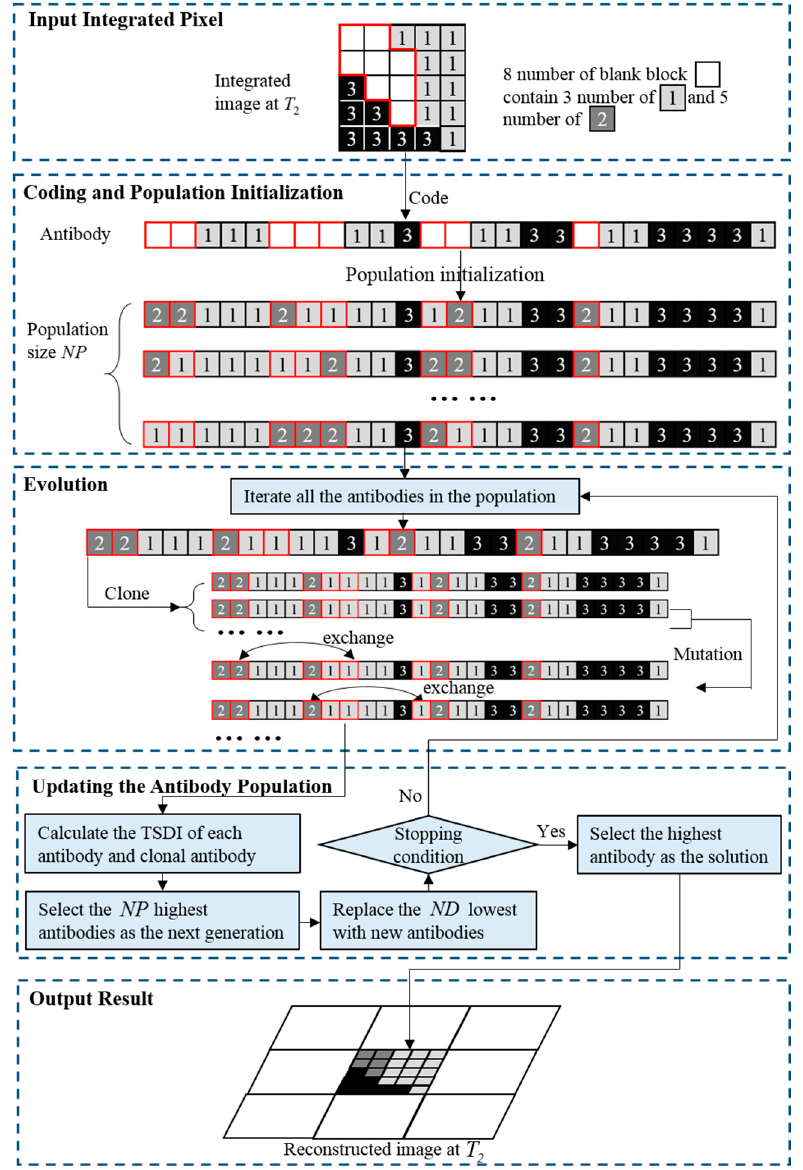
Figure 7. The framework of spatial-temporal sub-pixel mapping based on clonal selection.